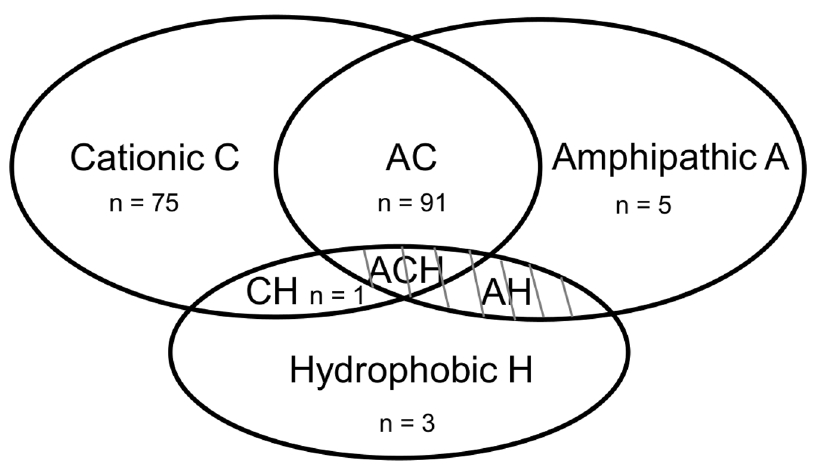
Table S3 Classification of (non-) CPPs based on chem- ical class, literature data and their uptake mechanisms. Table S4 Summary of the PCA-analysis of the descrip- tors divided by the molecular weight, describing the eigenvalues of the covariance matrix, the total variance explained (cumulative R 2 ) and the predictive ability (cumulative Q 2 ).